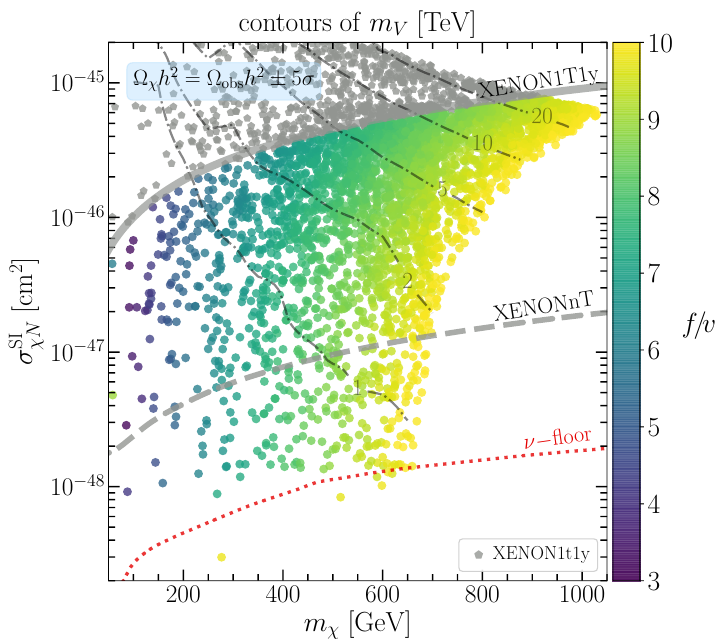
Figure 12 . The DM-nucleon cross section as a function of DM mass m (cid:31) with all points producing the observed relic abundance (cid:10) obs h 2 =0 : 12 0 : 0012. The gray points above gray curve are excluded (cid:6) by current XENON1T bounds, whereas the colored points (corresponding to particular f=v values) are